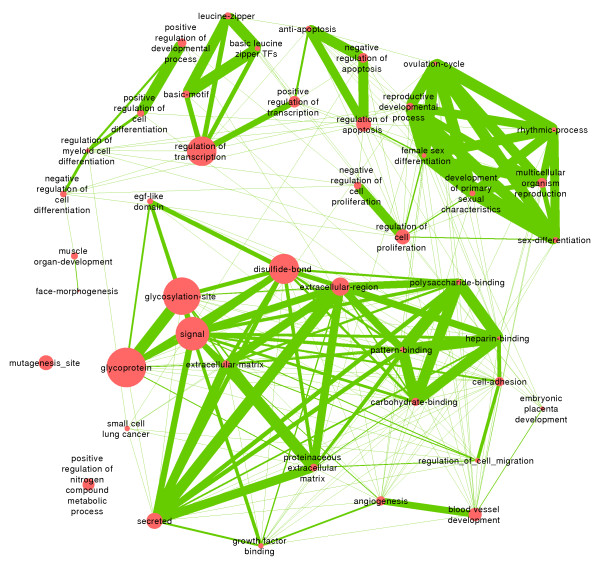
Clusters of significantly enriched functional groups among genes upregulated under hypoxia in at least 3 experiments. Nodes (circles) represent enriched gene ontology terms. Node size corresponds to the number of genes mapped to the term. Different pairs of terms (i.e., nodes) are connected by edges, where increased edge thickness corresponds to larger pairwise similarity, reflecting the proportion of shared genes.